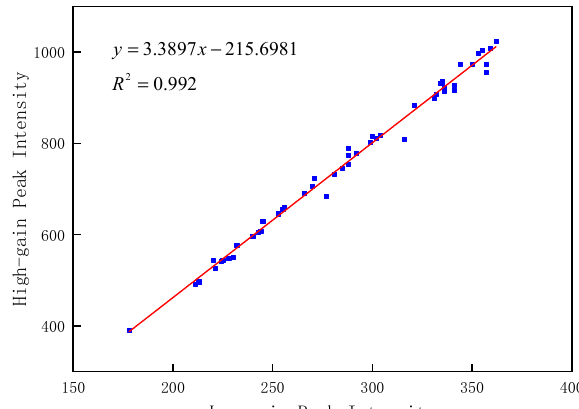
Figure 14. Fitting results of the high- and low-gain peak intensity regression model.